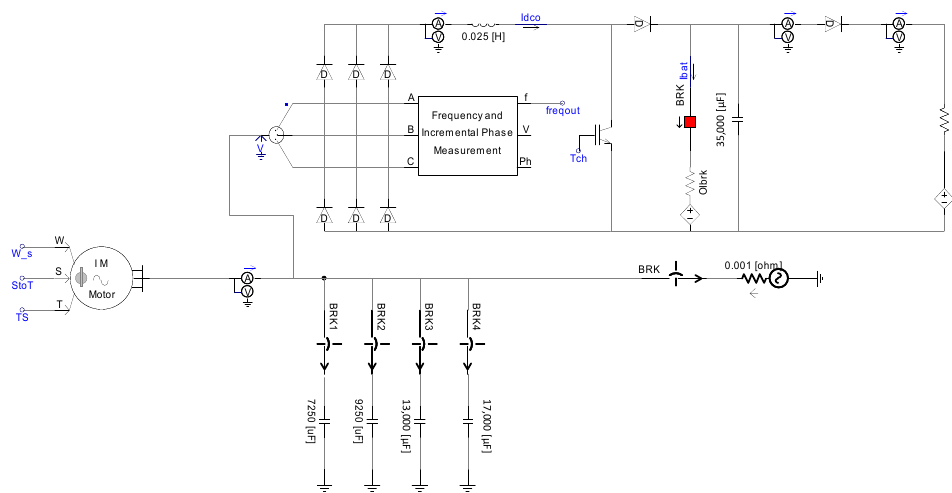
Figure 13. Overall system configuration with an electrolyzer.